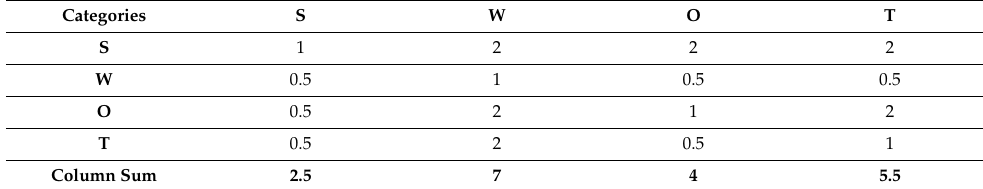
Table 8. Pairwise comparison between the SWOT categories of the factors.